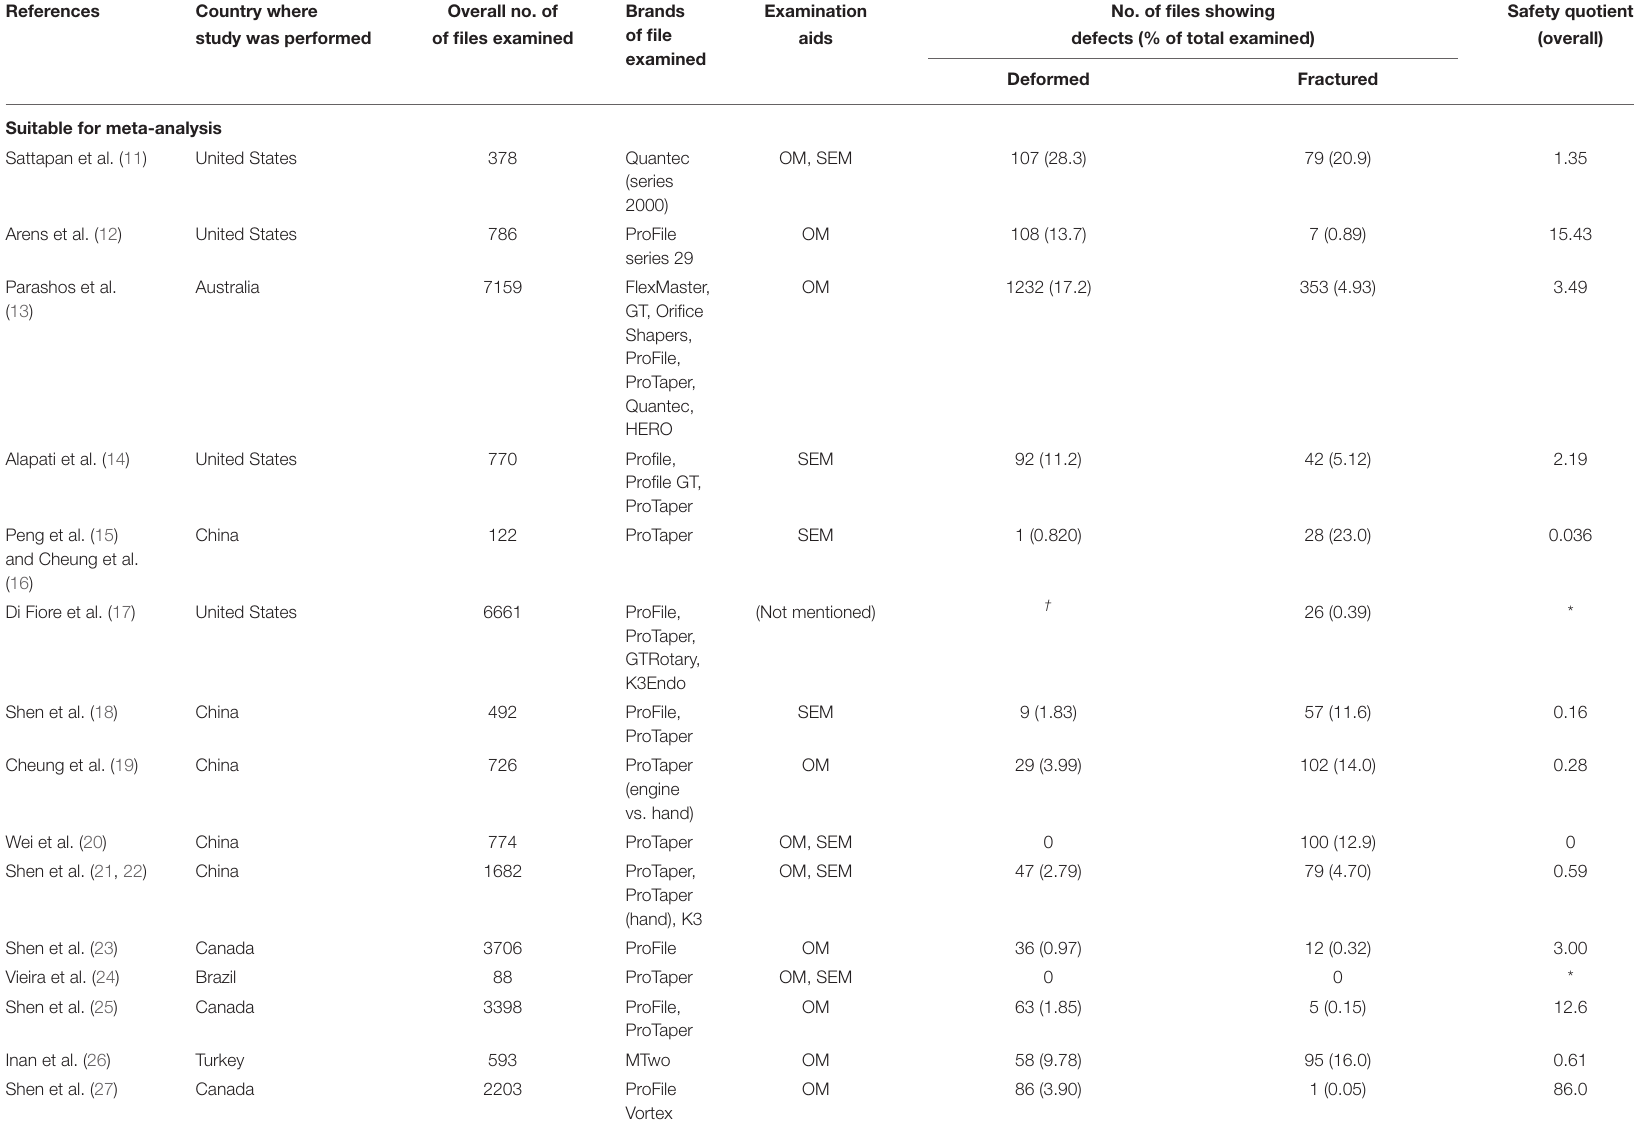
TABLE 1 | Characteristics of studies qualified for the